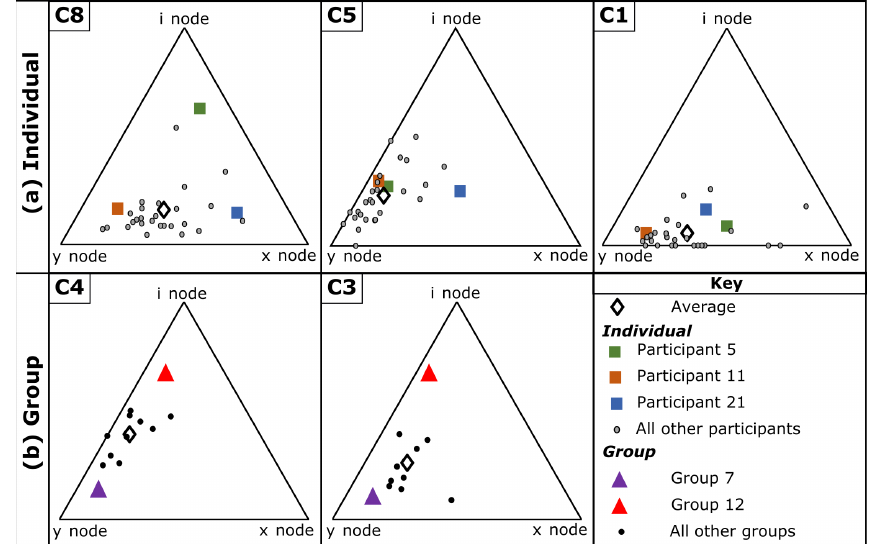
Figure 5. Node triangles for workshop participants and groups. For individual circles (a) , Participants 5, 21, and 11 were highlighted to show the consistency in the way participants classified nodes. Participants were selected according the whether they reported a low (P5), medium (P21), or high (P11) node count. Similarly, for group circles (b) Groups 7 and 12 were highlighted as groups who recorded a high and low node